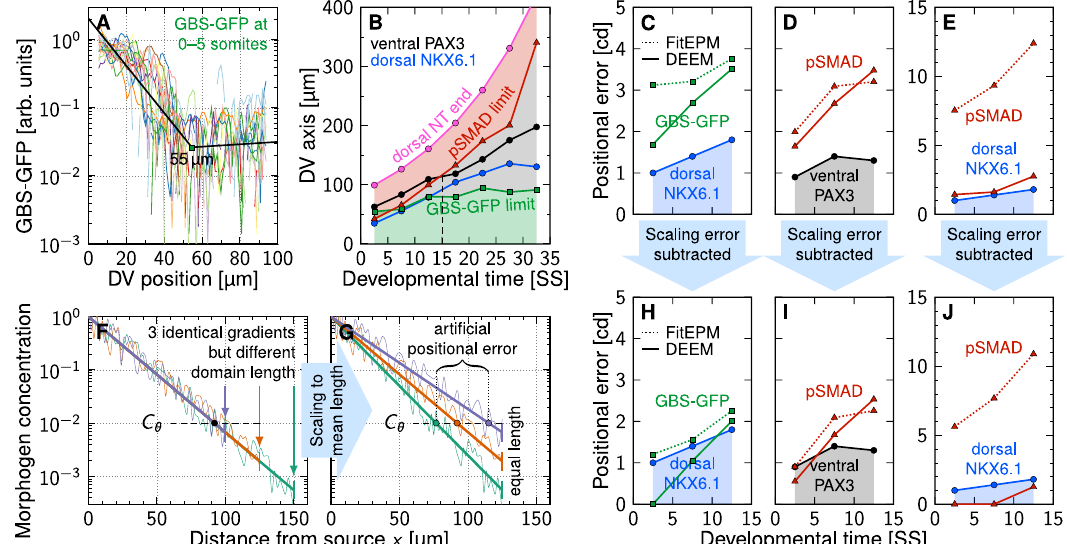
Fig. 2 Single gradients are precise enough to de fi ne the central progenitor domain boundaries in the mouse neural tube. A The GBS-GFP and pSMAD gradients 9 follow an exponential curve only close to the source and then transition to a noise bed, as revealed by fi tting a kinked line (black) to the logarithmic intensity with the kink position as free parameter (green square). B Exponential limit as obtained from the kink position in the GBS-GFP (green) and pSMAD (red) intensity pro fi les over time. The dorsal NKX6.1 (blue) and ventral PAX3 (black) domain boundaries (extracted from 9 ) lie within the exponential part of the gradients only during the fi rst 15 somite stages (dashed line). Later, they fall in the noise-dominated central region (gray). DV position in ( A , B ) is measured from the ventral end. C , D , E Comparison of the reported positional error evolution of the dorsal NKX6.1 ( C , E , blue) and ventral PAX3 ( D , black) domain boundaries to the positional error of the GBS-GFP ( C , green) and pSMAD ( D , E , red) gradients along these domain boundaries. Gradient errors determined either with the FitEPM (Eq. (14), dotted lines) or the DEEM (Eq. (2), solid lines), in units of cell diameters (cd). The shaded region indicates the range into which the gradient positional errors (green, red) would need to fall for the gradients to be precise enough to directly explain the measured domain boundary precision. F , G Rescaling the domains to the mean domain length changes the decay length and introduces an arti fi cial positional error. H , I , J After subtraction of the domain scaling error introduced in 9 , the gradients' positional errors (green, red) are suf fi ciently low to be consistent with the reported dorsal NKX6.1 (blue) and ventral PAX3 (black) boundary errors. Source data are provided as a Source Data fi